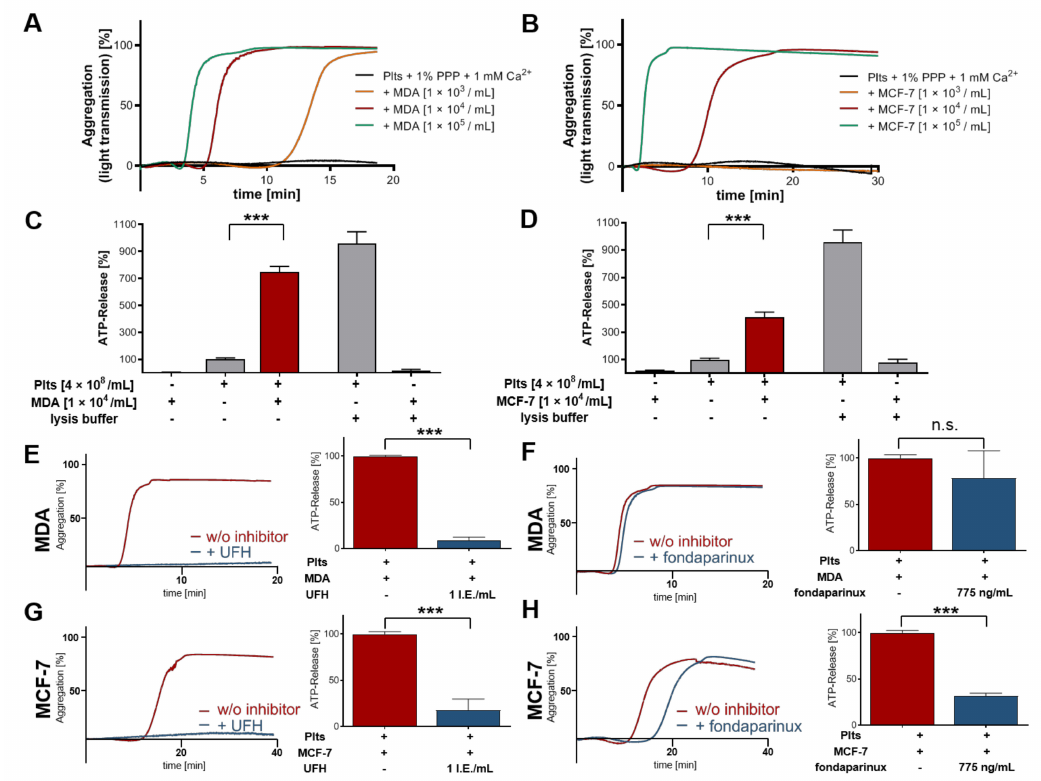
Figure 1. Tumor cell-induced platelet secretion and aggregation. ( A , B ) Representative traces showing platelet-tumor cell aggregation in response to increasing concentrations of (A) MDA-MB-231 cells for 20 min ( n = 5) or (B) MCF-7 cells for 30 min; ( C ) quantification of ATP release from resting platelets, 1 × 10 4 MDA-MB-231 cells / mL, platelets co-incubated with 1 × 10 4 MDA-MB-231 cells / mL for 30 min, platelets treated with 1% Triton X-100, or MDA-MB-231 cells (1 × 10 4 cells / mL) treated with 1% Triton X-100, respectively; ( D ) quantification of ATP release from resting platelets, MCF-7 cells, platelets co-incubated with MCF-7 cells for 30 min, platelets treated with 1% Triton X-100, or MCF-7 cells (1 × 10 4 cells / mL) treated with 1% Triton X-100, respectively; ( E ) representative traces showing platelet aggregation in response to MDA-MB-231 cells (1 × 10 4 / mL) or MCF-7 cells (1 × 10 4 / mL) ( n = 5). Platelets were preincubated with 1 IU / mL UFH (left part of the figure) ( n = 5). Quantification of ATP release from MDA-MB-231 (1 × 10 4 / mL) cell or MCF-7 (1 × 10 4 / mL) cells stimulated platelets preincubated with 1 IU / mL UFH ( n = 5) (right part of the figure); ( F ) representative traces showing platelet aggregation in response to MDA-MB-231 cells (1 × 10 4 / mL) or MCF-7 cells (1 × 10 4 / mL) ( n = 5). Platelets were preincubated with 775 ng / mL fondaparinux (left part of the figure) ( n = 5). Quantification of ATP release from MDA-MB-231 (1 × 10 4 / mL) cell or MCF-7 cells (1 × 10 4 / mL) stimulated platelets preincubated with 775 ng / mL fondaparinux ( n = 5) (right part of the figure). *** p < 0.001 indicated statistical